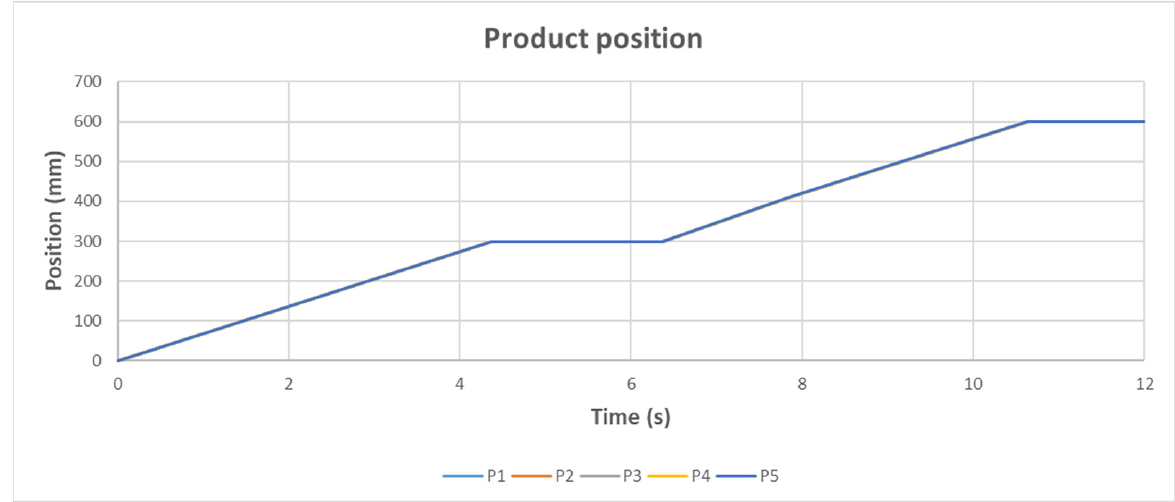
Figure 12. Event-based control product position results in a regular case.